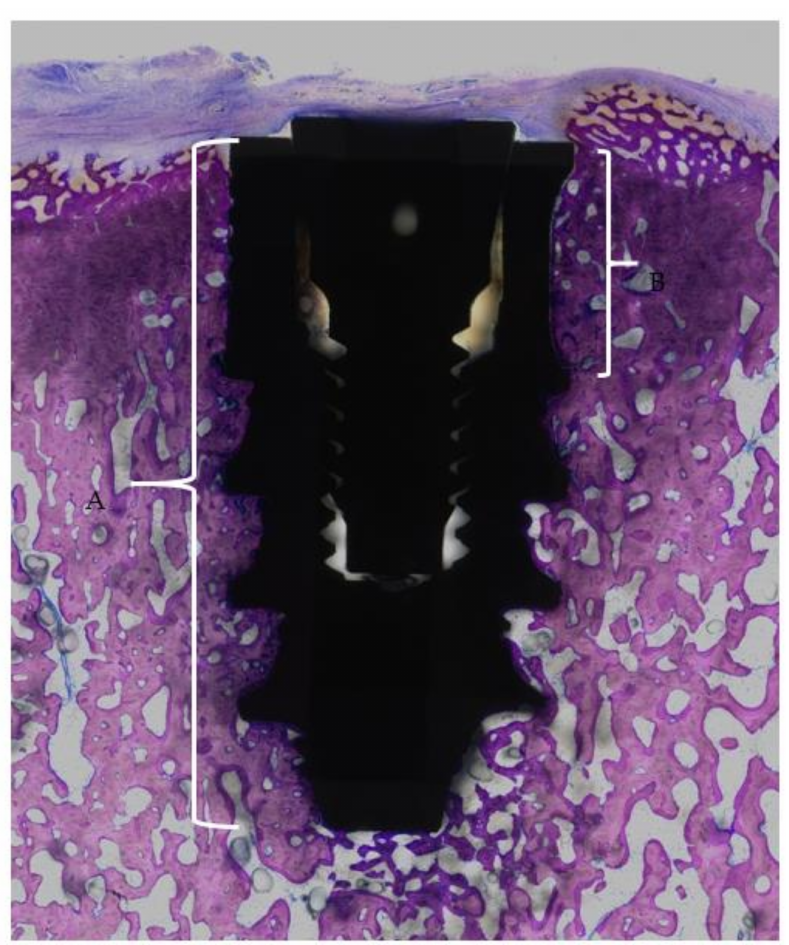
Figure 3. Micrograph of a whole implant. A represents the region of total bone-to-implant contact (t-BIC). B represents the region of the coronal third of cortical bone-to-implant contact (flute-BIC). Magnification, 10 ×